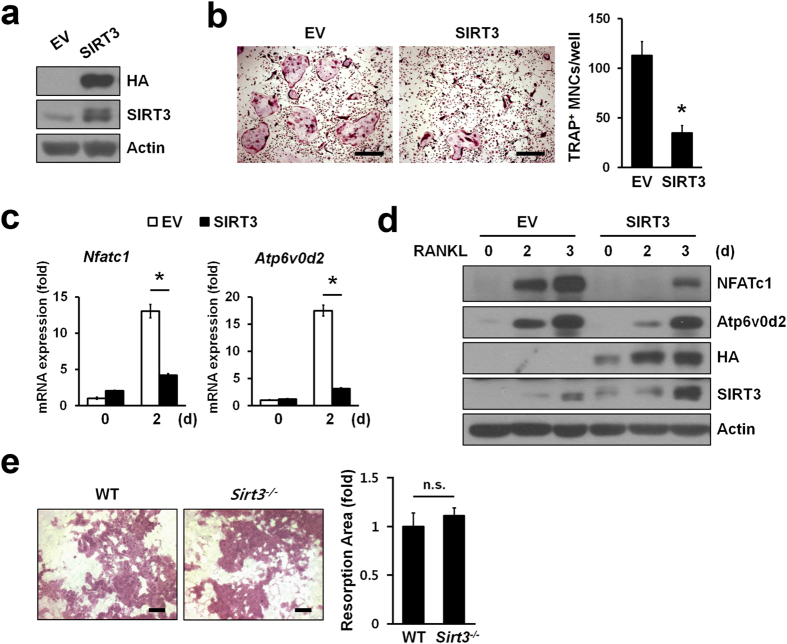
SIRT3 negatively regulated osteoclast differentiation but not function.(a) BMMs were infected with retroviruses expressing HA-tagged SIRT3 or empty vector (EV). SIRT3 protein levels in whole cell lysates were detected by immunoblotting with anti-HA or anti-SIRT3 antibody. Actin serves as a loading control. (b) Osteoclast differentiation in BMMs infected with SIRT3 or EV. TRAP+MNCs (>3 nuclei) were counted. Scale bar, 500 μm. *P < 0.01. Data are represented as mean ± SD. (c,d) Expression of Nfatc1 and NFATc1-induced genes Atp6v0d2 during osteoclastogenesis. Infected BMMs were treated with RANKL for indicated days, and then subjected to qRT-PCR (c) or immunoblot analysis (d), respectively. Actin serves as a loading control. *P < 0.005 between the indicated groups. Data are represented as mean ± SD. (e) Bone resorption activity of WT or Sirt3−/− osteoclasts. After differentiation of BMMs into osteoclasts, cells were seeded onto dentine discs and further incubated with RANKL for 3 days. The cells were removed from the dentine discs and stained with hematoxylin for visualization of pit formation. The area of resorption pits were measured with Image-Pro Plus 4.5 (Media Cybernetics). Data are represented as mean ± SD. Scale bar, 100 μm. n.s., not significant.